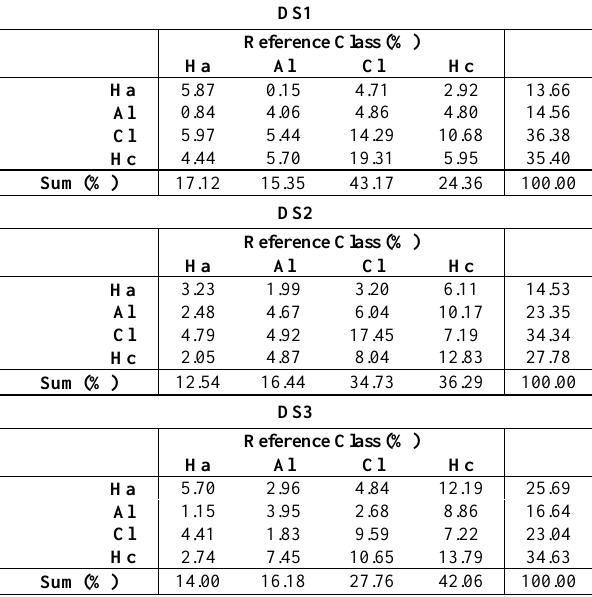
Table 4. Confusion matrix for the data sets classified with SAM